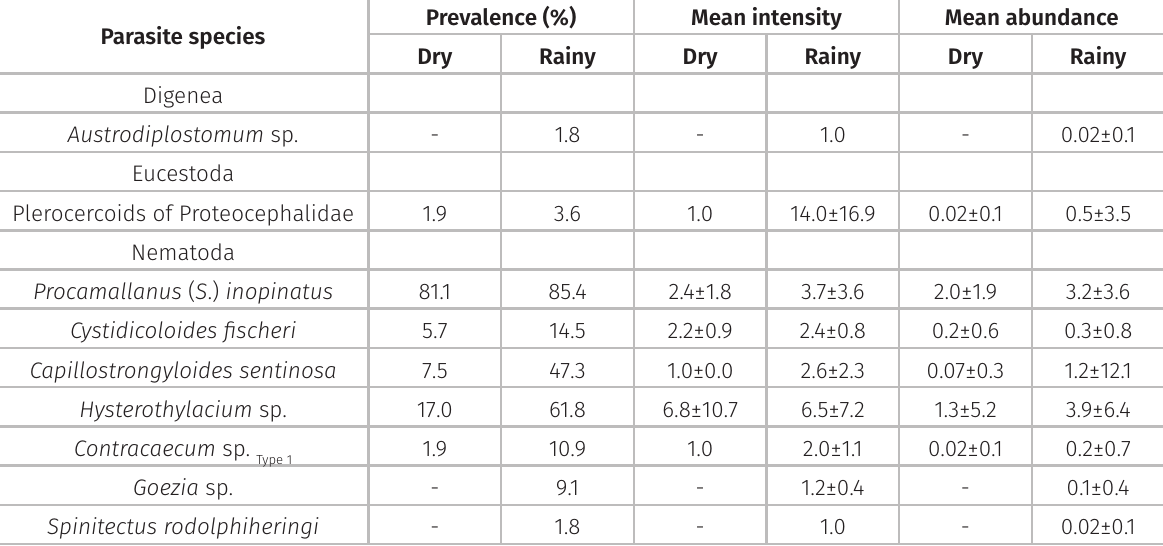
Table VIII. Prevalence, mean intensity, and mean abundance of the metazoan endoparasites of Pygocentrus piraya in the respective collection period (dry and rainy seasons), from Três Marias reservoir, upper São Francisco river, state of Minas Gerais,